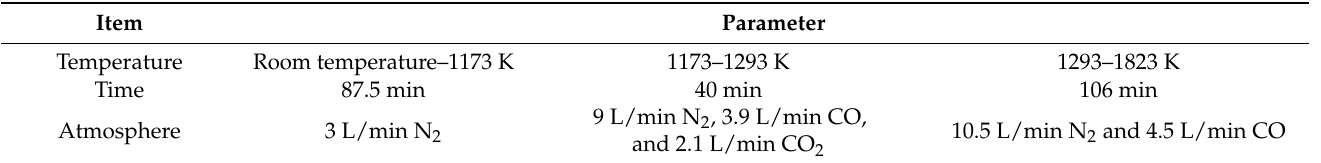
Table 6. Chemical composition of the sinter (wt,